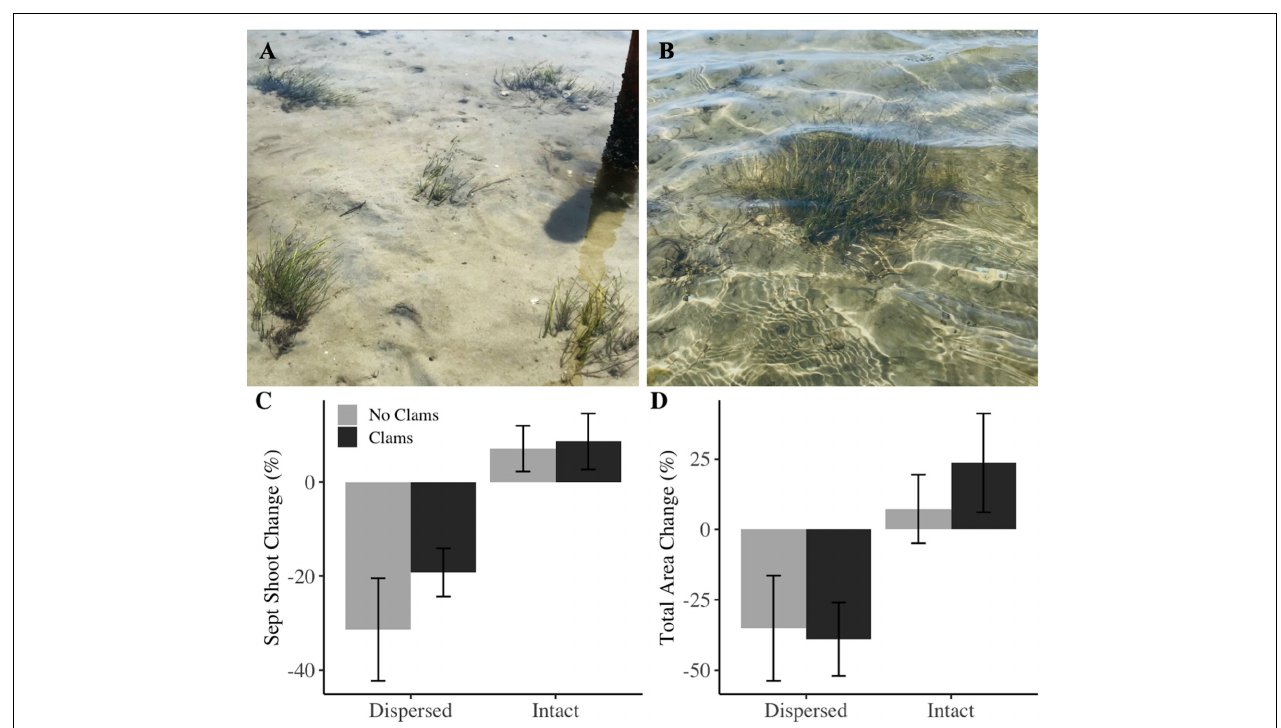
FIGURE 4 | Configurations of (A) dispersed and (B) single-intact plots. Photos taken approximately 1 month after planting in July 2018. Interactive and separate effects of adult planting configuration and clam addition from ANOVA tests indicated that clams did not alter productivity; rather, intact patches had significantly greater (C) proportional change in shoot density from August to September, and (D) total change in patch area over the entire experimental duration from June to September than several-dispersed configurations. Error bars represent one standard